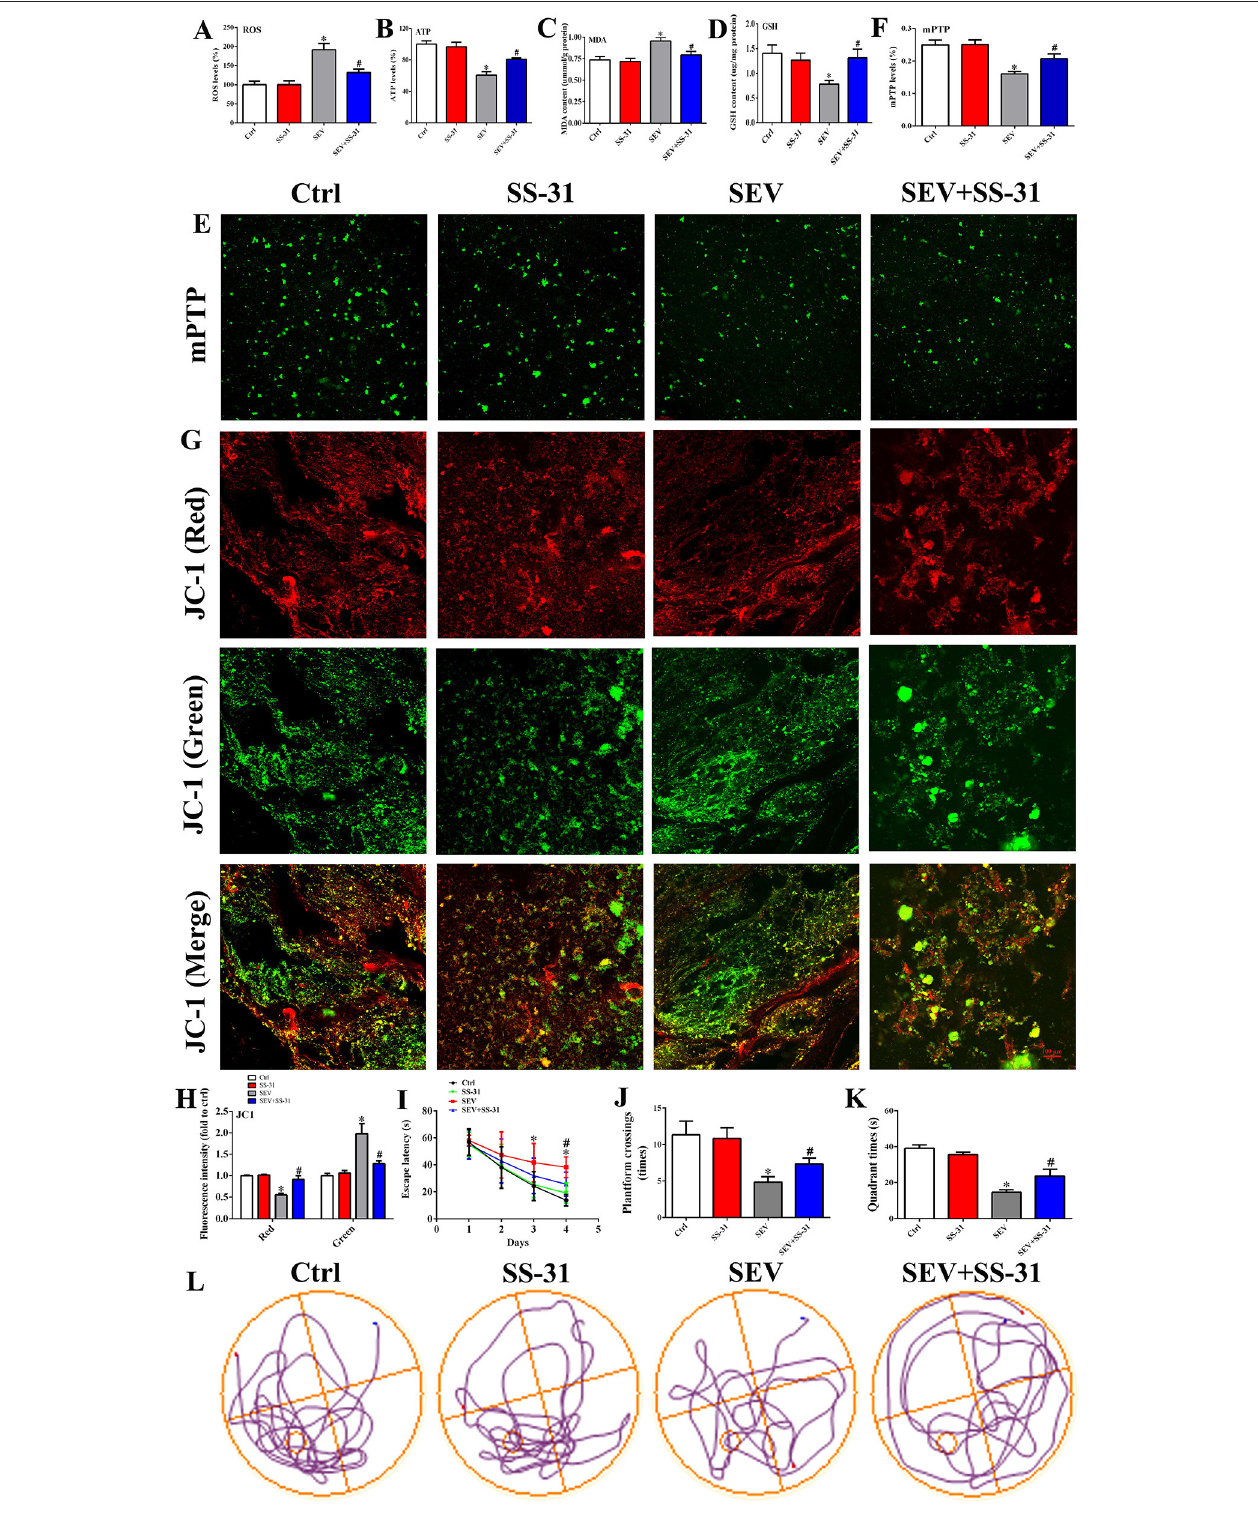
FIGURE 6 | SS-31 treatment alleviated sevoflurane-induced cognitive deficits by enhancing mitochondrial function. (A) Detection for ROS accumulation in hippocampus [one-way ANOVA, Tukey’s multiple comparisons test, Treatment: F (3,20) = 13.68, mean difference (95% CI): − 91.74 ( − 138.0 to − 45.49) (Ctrl vs.